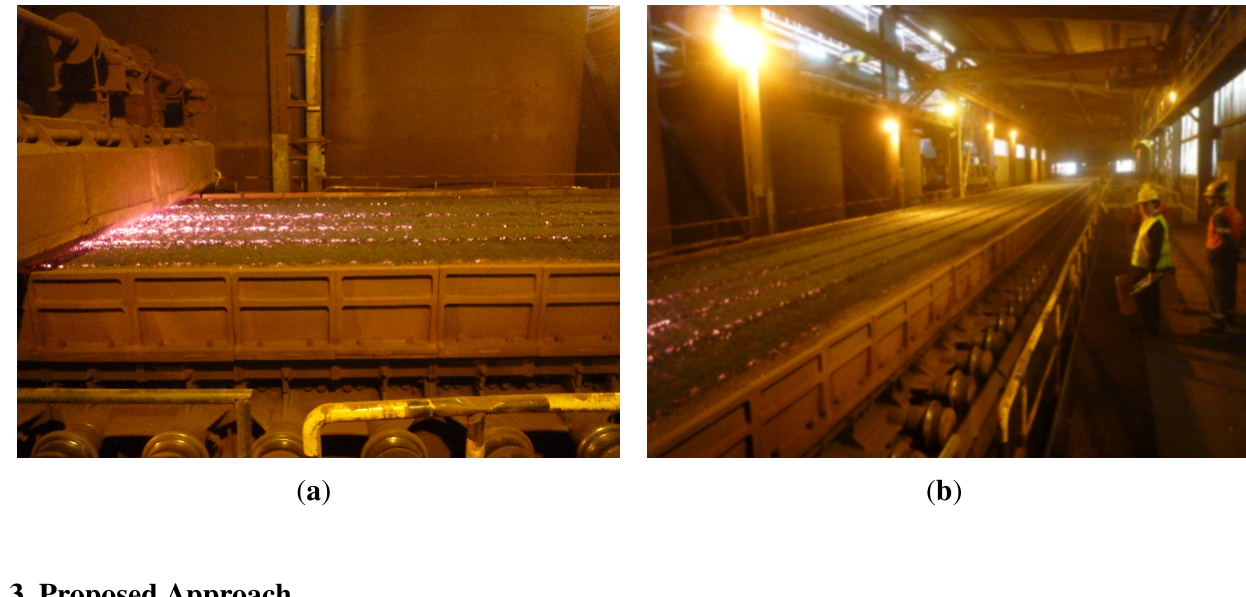
Ignition hood and sinter